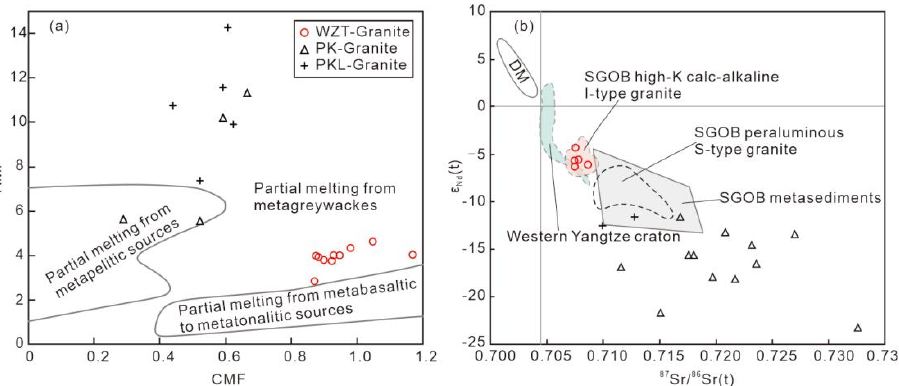
Figure 9. Binary diagrams showing the source of the Wuzhutang granite from the Xuebaoding mining area, Sichuan Province, China. ( a ) Plot of CMF vs. AMF (CMF-CaO/(MgO + FeO T ); AMF- Al 2 O 3 /(MgO + FeO T ) (after [72]) of the Wuzhutang granite. ( b ) Plot of 87 Sr/ 86 Sr(t) vs. Nd (t) of the Wuzhutang granite. Sr–Nd isotopic data of the SGOB high-K calc–alkaline I-type granite is from [73,74], that of the SGOB peraluminous S-type granite is from [47,74,75], that of the SGOB metasediments is from [47,74], that of the western Yangtze craton is from [74]; geochemical data of the Pankou and Pukouling granites are from [38,39].